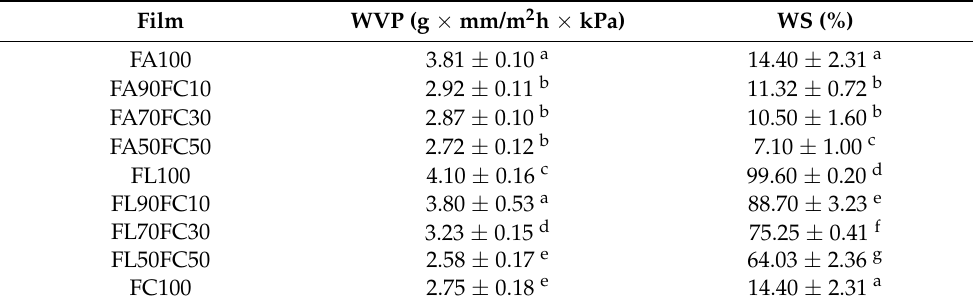
Table 3. Water vapor permeability (WVP) and water solubility (WS) of the films. ANOVA and LSD were performed. Different letters in the same column indicate significant differences ( p <